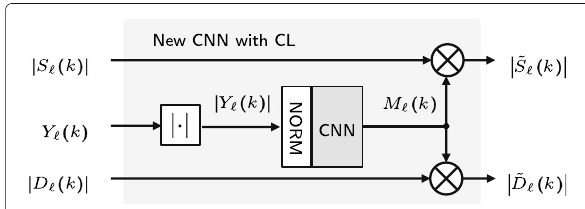
Fig. 3 Proposed CNN training setup for speech enhancement according to the white-box approach . The hereby applied components loss (CL) is given in (8) and